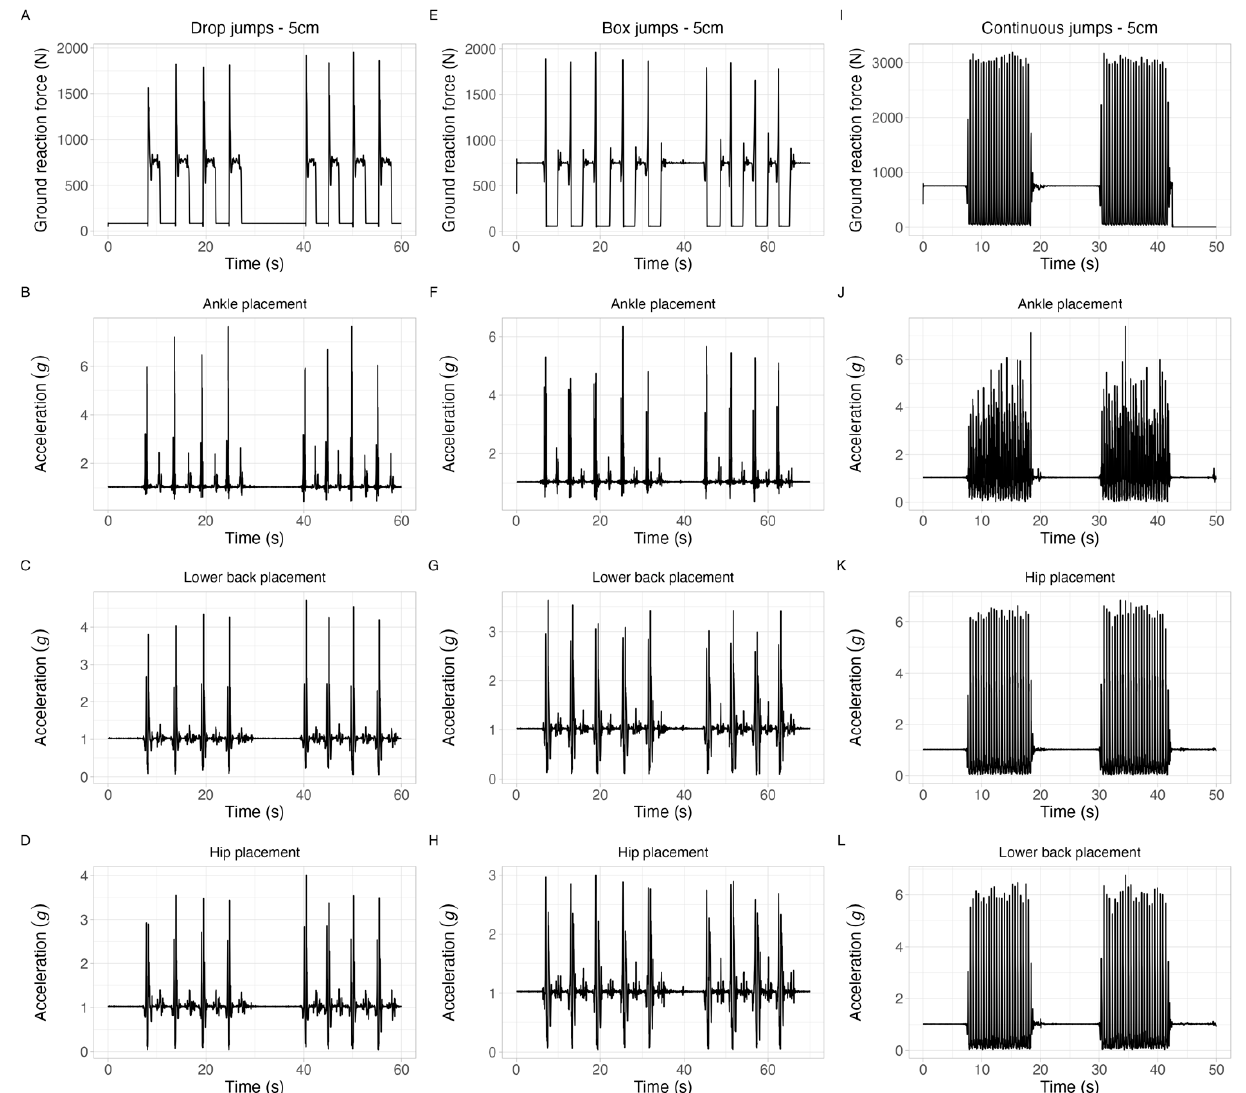
Figure 5. Examples of the ground reaction force and acceleration signals for all of the jump types performed. The first column, formed by Panels ( A – D ), shows the ground reaction force and acceleration signal for accelerometers at the ankle, lower back, and hip for the drop jump from 5 cm height. Panels ( E – H ) show the same signals, but for the box jumps of 5 cm height, while Panels ( I – L ) show the signals for the continuous jumps of 5 cm.